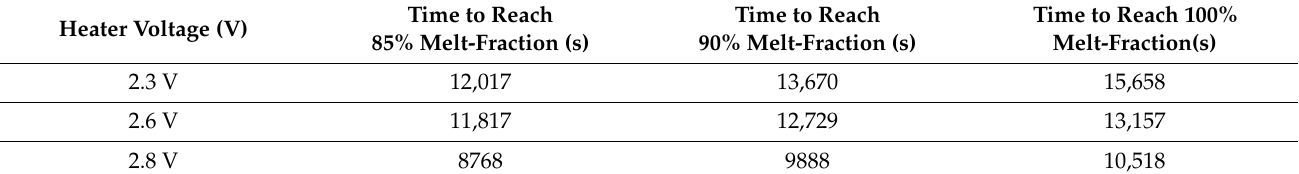
Table 2. Time to reach specific values of melt-fraction for different values of power input to the heater. Heater Voltage (V)